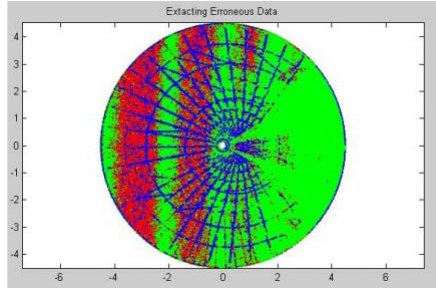
Figure 7: Classification of points. Green and red points denote surface and high curvature points, respectively. Blue denote discontinuities in local curvature information. The axes represent the local x and y coordinate system of the dish, with the bottom of the dish (closest to the ground) towards the right of the